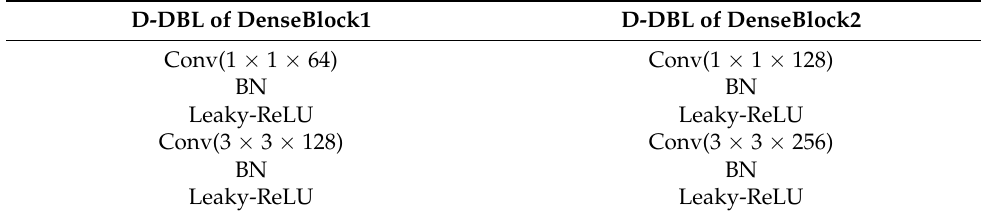
Table 1. The internal channel information from the transport layer.